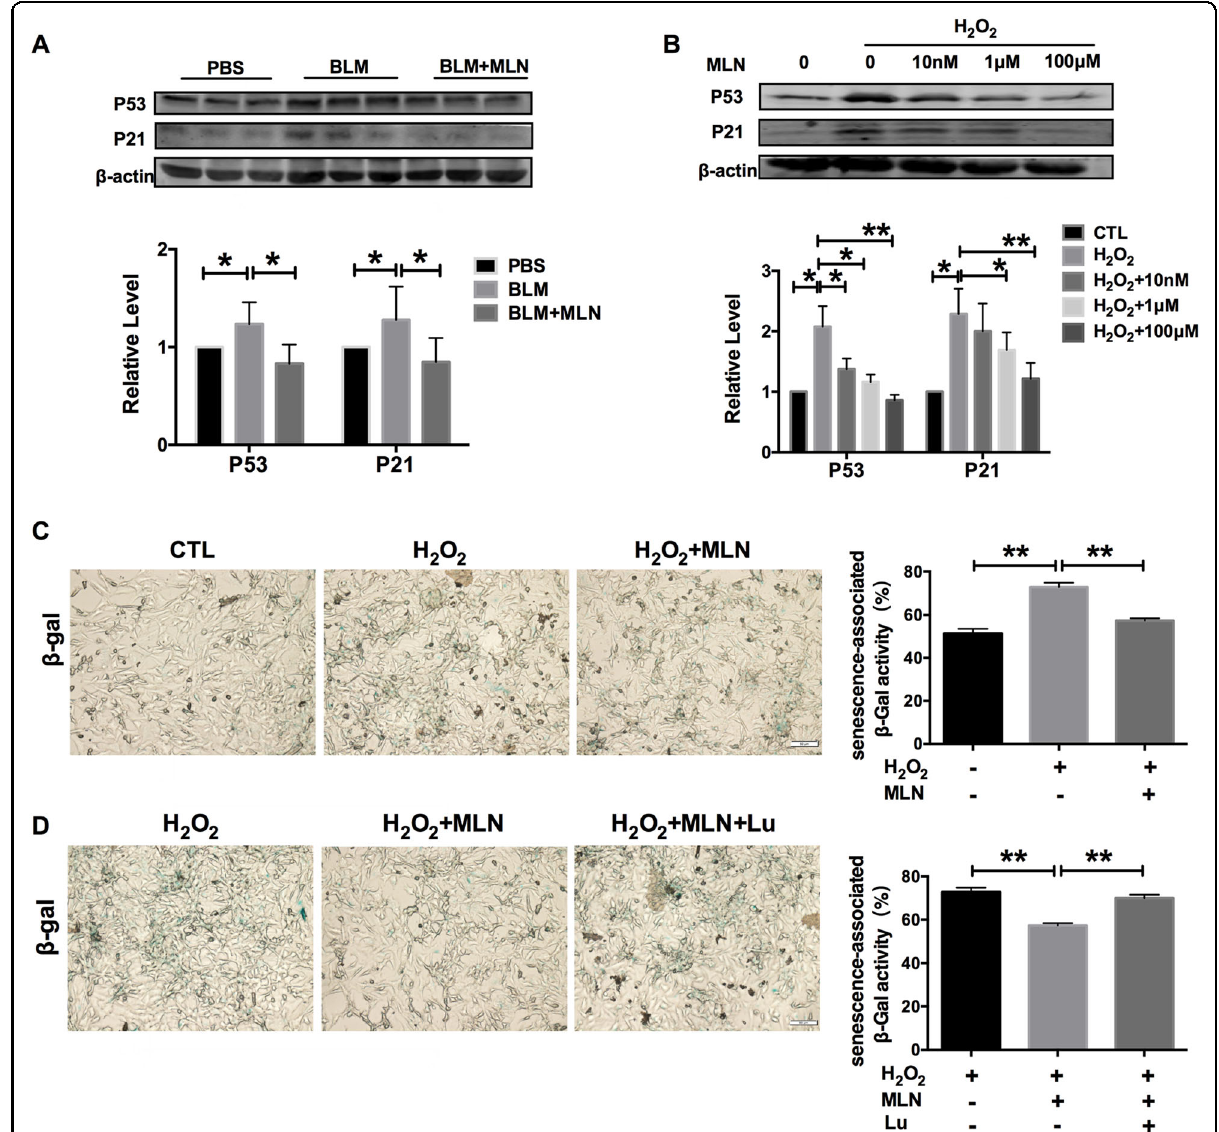
Fig. 3 Melatonin inhibited senescence during lung injury. a Western blot analysis of the expression of p53 and p21 in whole lungs from mice in the PBS, BLM, and BLM + MLN groups. * P < 0.05. b Western blot analysis of p53 and p21 expression in TC-1 cells. * P < 0.05, ** P < 0.01. c β -Gal staining showed increased senescence-associated β -gal activity in TC-1 cells 12 h after H 2 O 2 treatment, and treatment with 100 μ M melatonin reversed senescence in these cells. Scale bar, 50 μ m. ** P < 0.01. d Luzindole signi fi cantly blocked melatonin-induced senescence, as evidenced by staining for senescence-associated β -gal activity. Cells with green staining are senescent cells. Scale bar, 50 μ m. ** P <